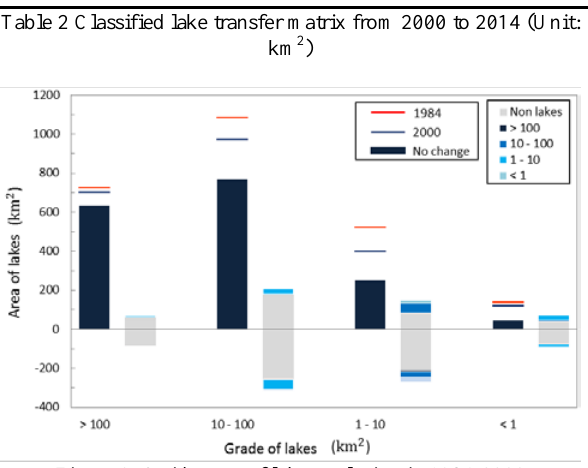
Figure 3. Guide map of lake evolution in 1984-2000